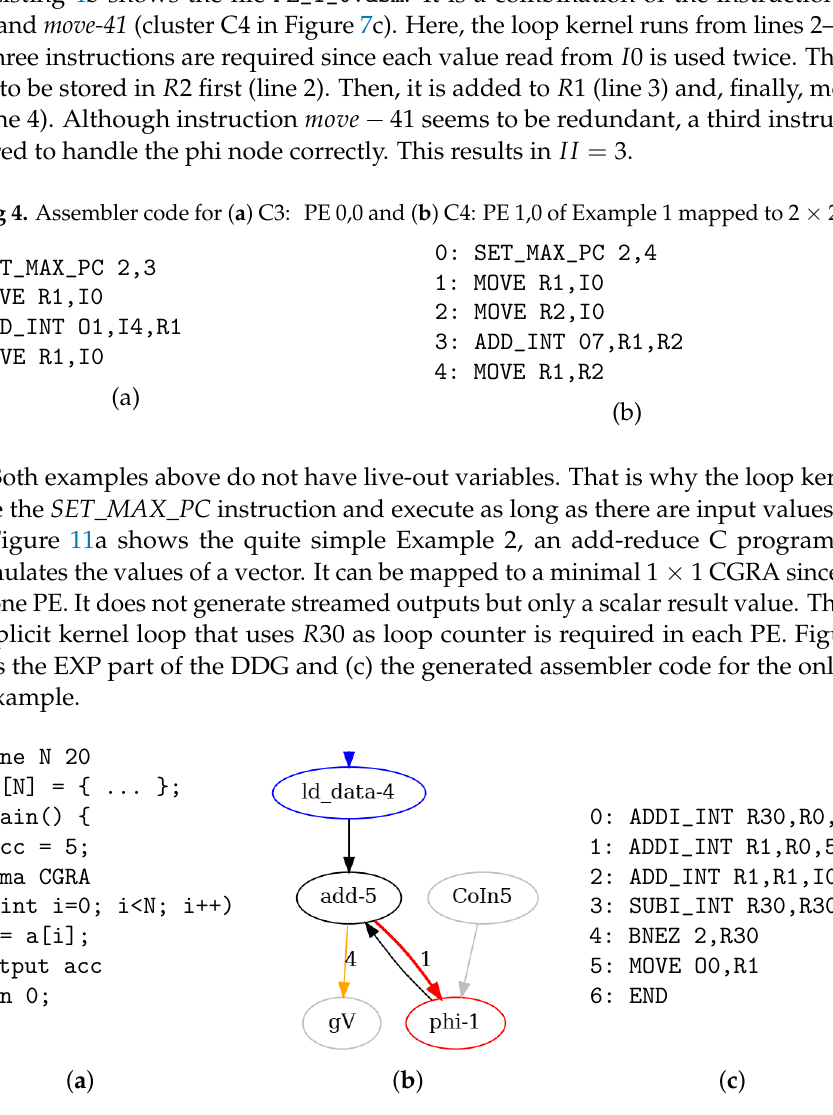
Figure 11. Example 2: ( a ) Add-reduce C program, ( b ) EXP part of DDG and ( c ) assembler